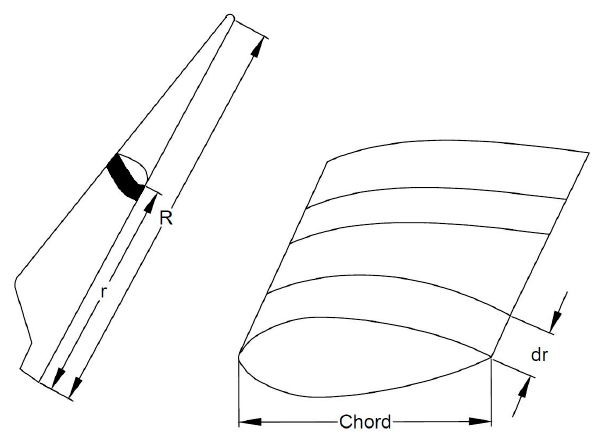
Figure 3. DU-00-W-401 airfoil lift and drag coefficients [35].